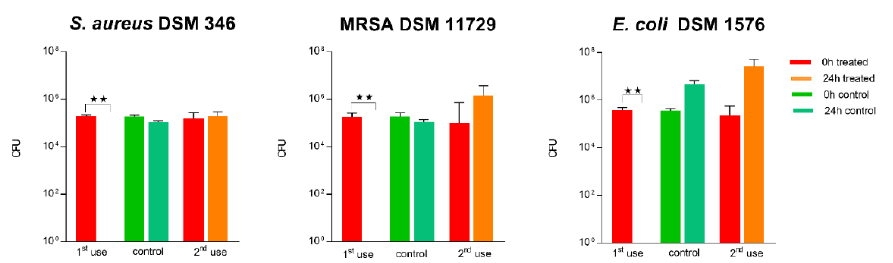
Figure 8. Quantification of viable bacteria using ISO 22196 at first use and at second use. Surfaces were wiped down with paper towels wetted with 70% ethanol. The results of two independent experiments are shown. A volume of 100 µ L of bacterial inoculum was incubated at 99% humidity and 37 ◦ C for 24 h on the 2.5% Cu(NO 3 ) 2 -containing sol–gel surface, as well as a sol–gel surface without additive (control). The initial number of bacteria was quantified immediately after inoculation and after 24 h of incubation. Mean numbers of bacteria per surface (CFU) are displayed on a logarithmic scale with error bars indicating the standard deviation of the respective means. Statistically significant differences between the number of viable bacteria after 24 h of incubation are marked. (Mean with 95% CI, Mann–Whitney-U test; ** corresponds to p ≤ 0.004).